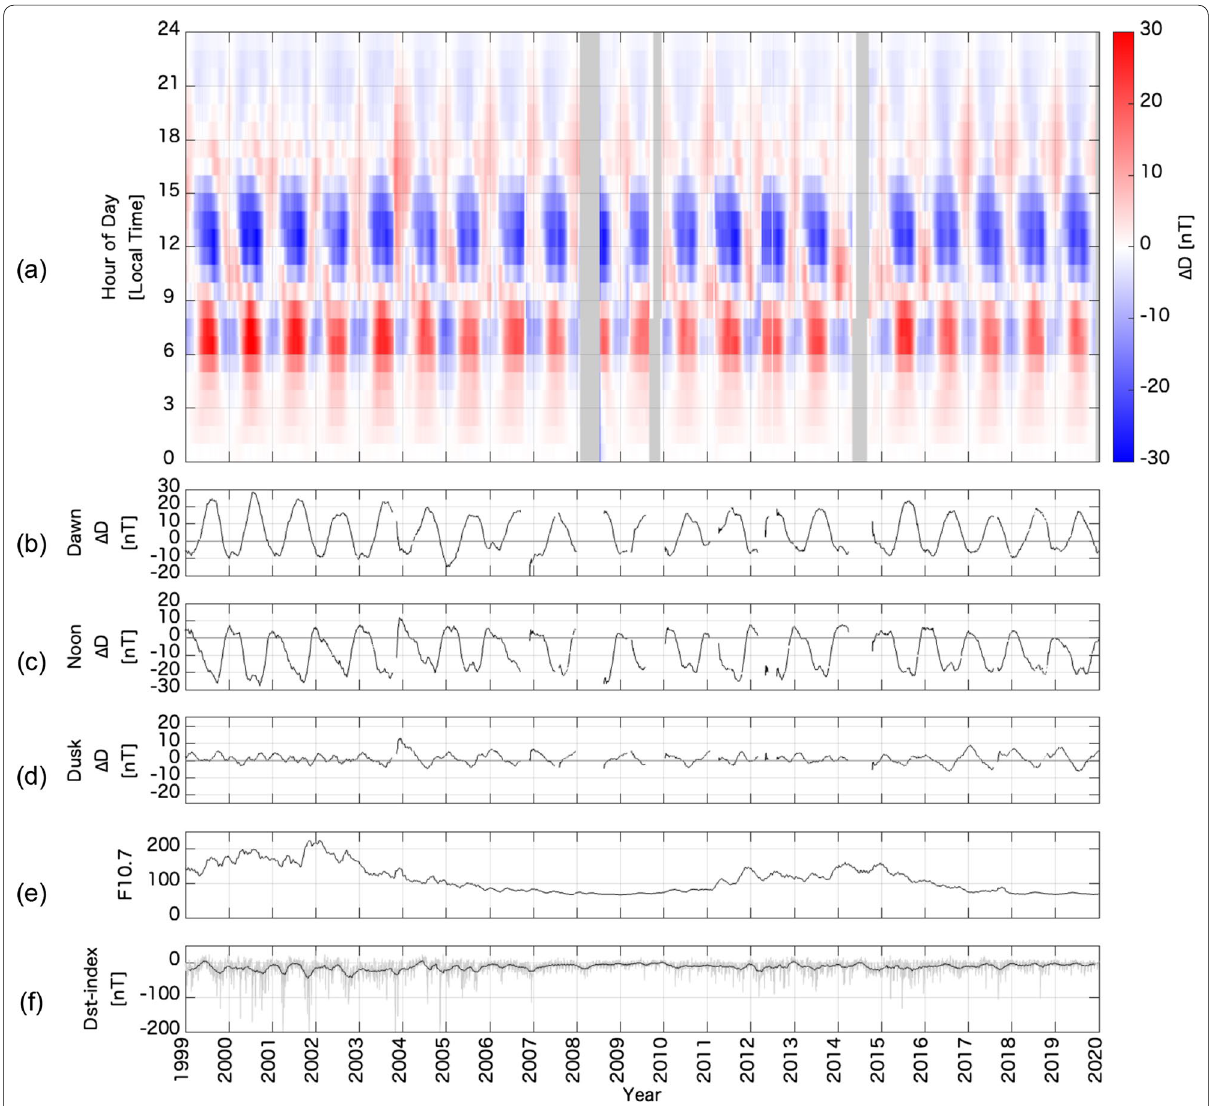
Fig. 4 Long-term ∆ D variation with F10.7 and Dst index, from 1999 to 2019. a 61-day centered moving-averaged ∆ D respect to each local time (LT), gray shade patch indicates the lack of data; b 61-day centered moving-averaged ∆ D in dawn sector (06–08 h, LT); c 61-day centered moving-averaged ∆ D in noon sector (11–13 h, LT); d 61-day centered moving-averaged ∆ D in dusk sector (16–18 h, LT); e 61-day centered moving-averaged daily F10.7 index; f daily Dst index and 61-day centered moving-averaged daily Dst index are plotted with gray and black solid lines,